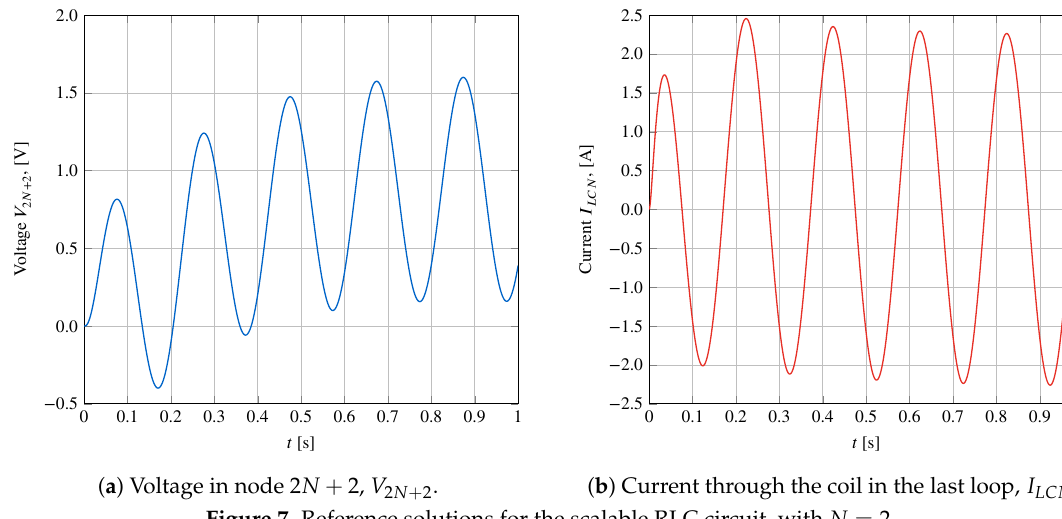
Figure 7. Reference solutions for the scalable RLC circuit, with N =